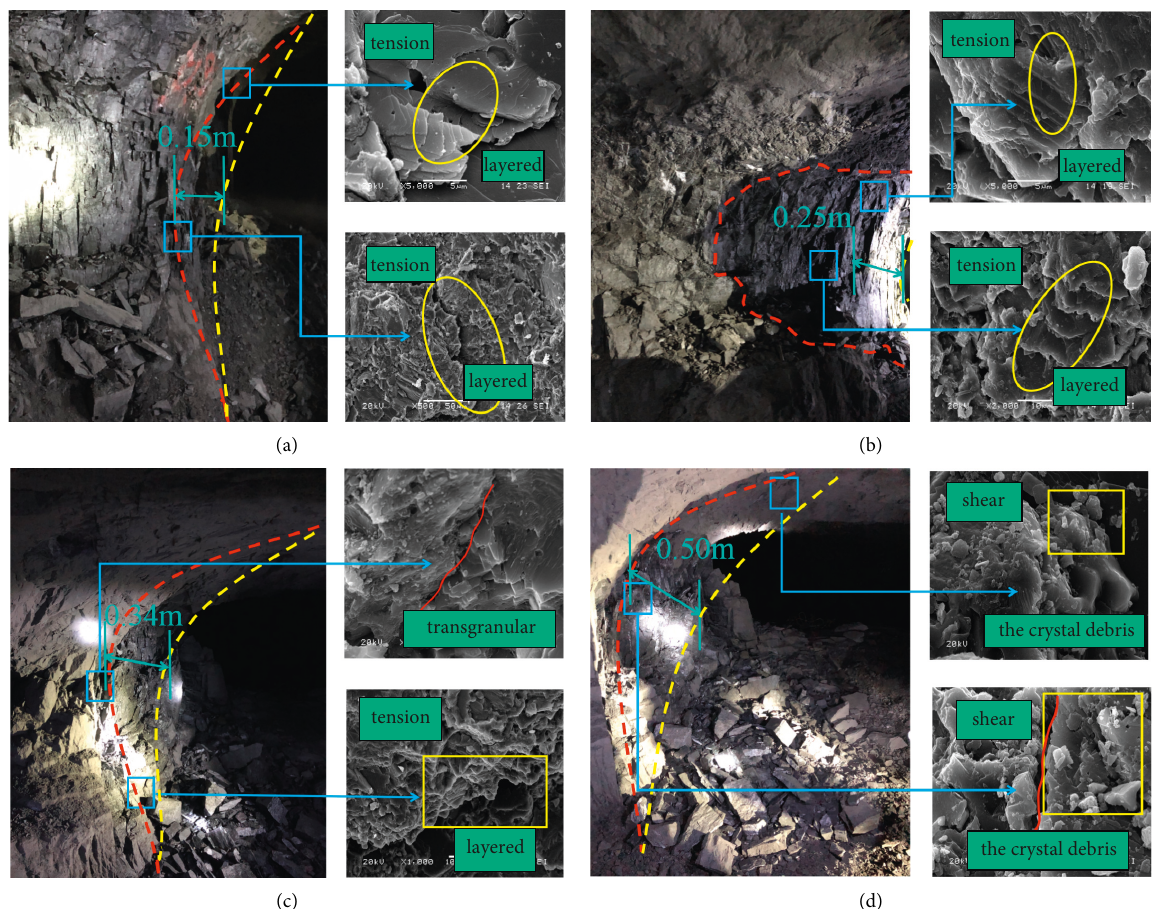
Figure 16: A phosphate rock burst failure area in Yichang, Hubei Province and surrounding rock fracture surface scanning electron microscopy. (a) Rock burst section 1. (b) Rock burst section 2. (c) Rock burst section 3. (d) Rock burst section